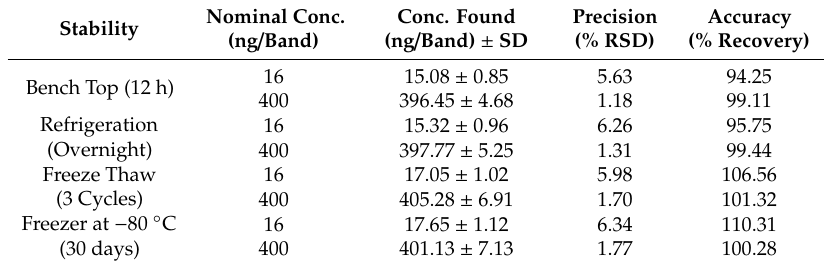
Table 5. Stability evaluation of DLX at two di ff erent concentrations (LQC and HQC) ( n =